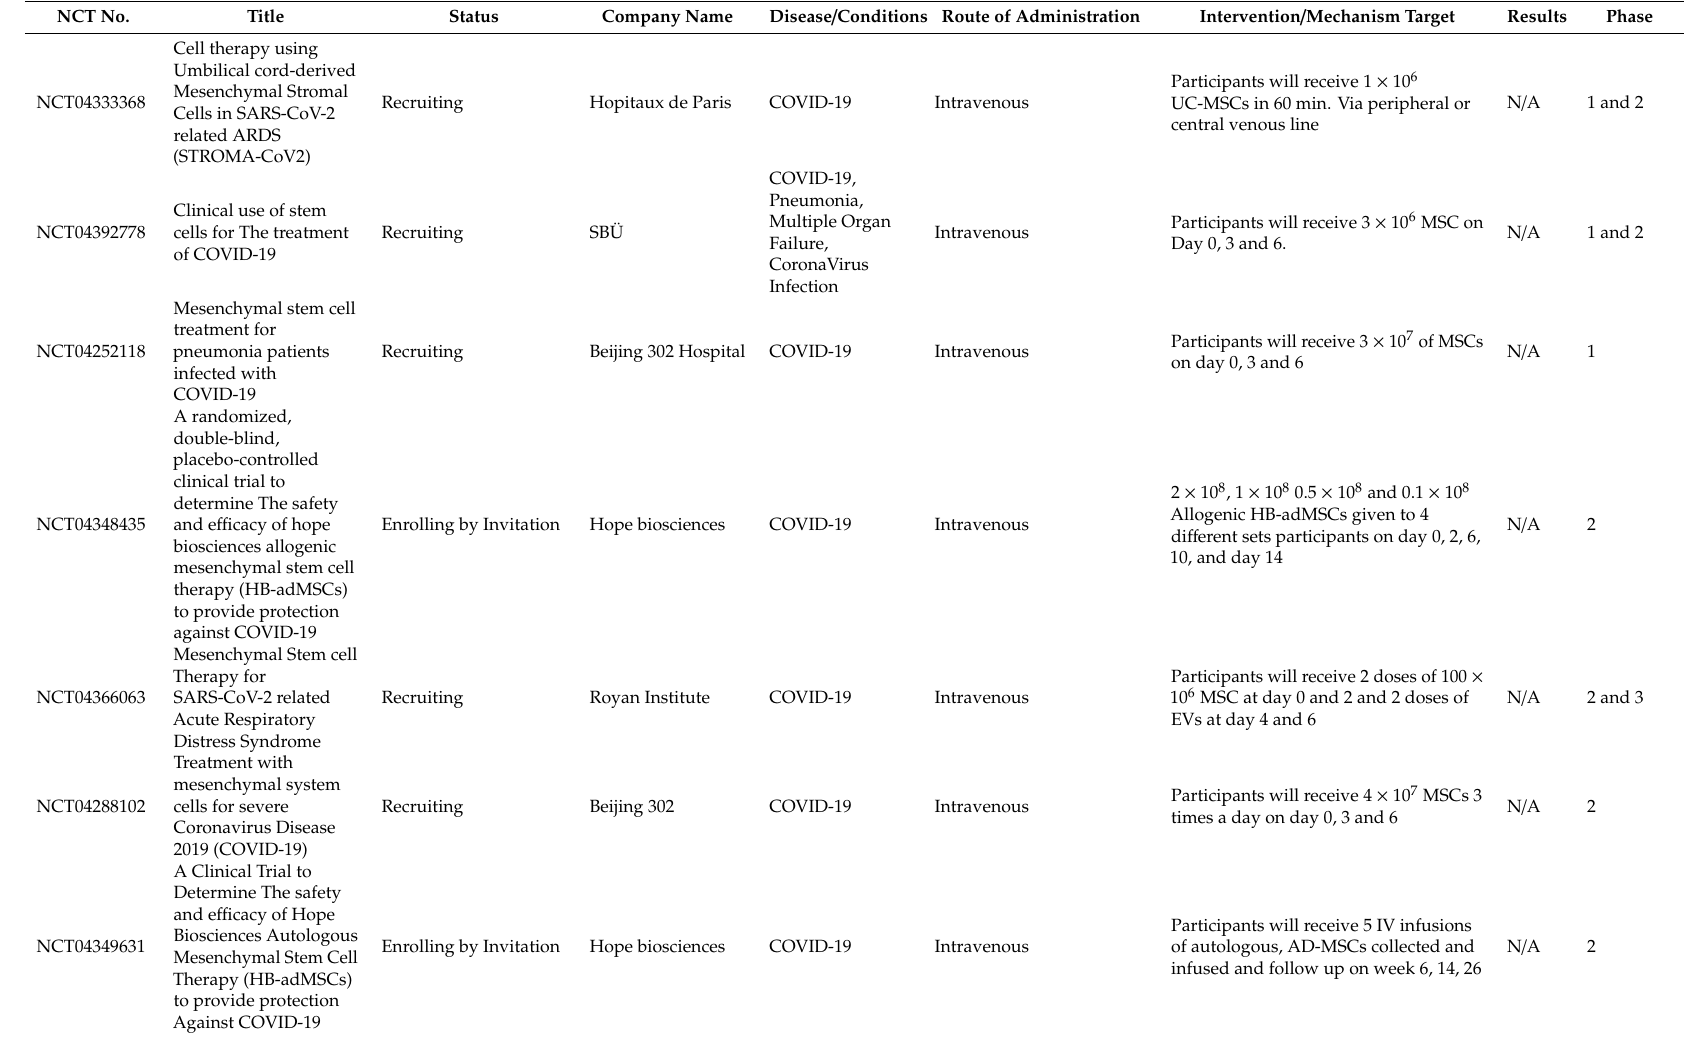
Table 3. MSC based therapy clinical trials for